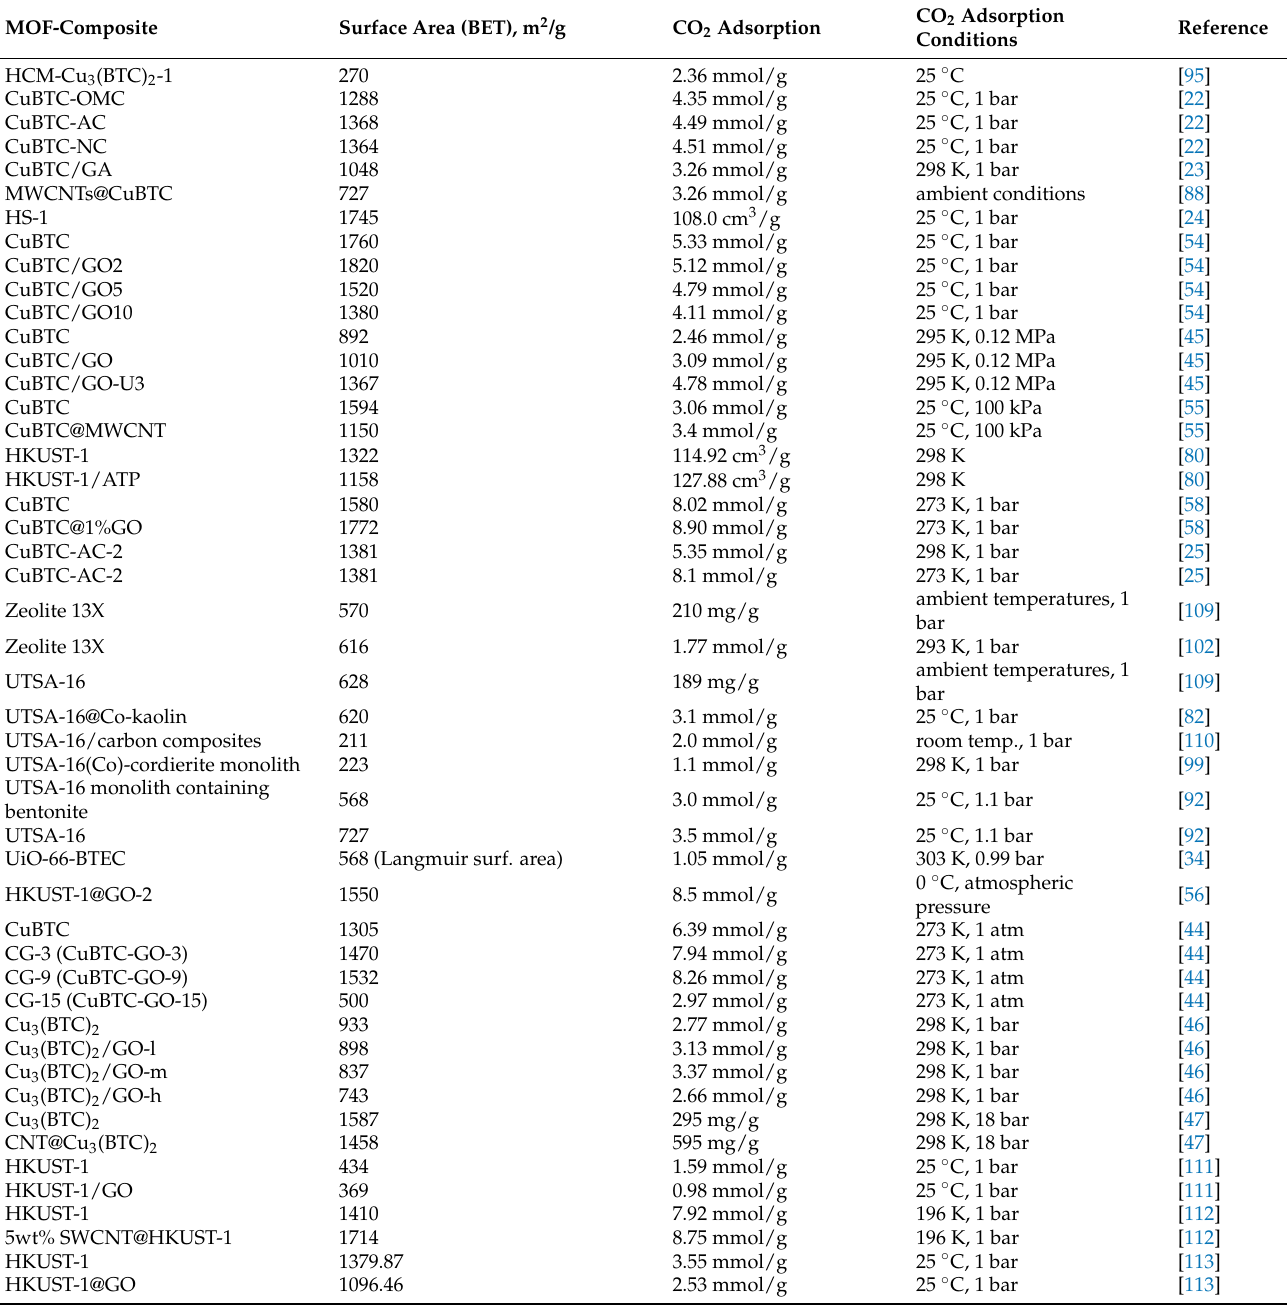
Table 1. MOF and MOF-composite CO 2 adsorption